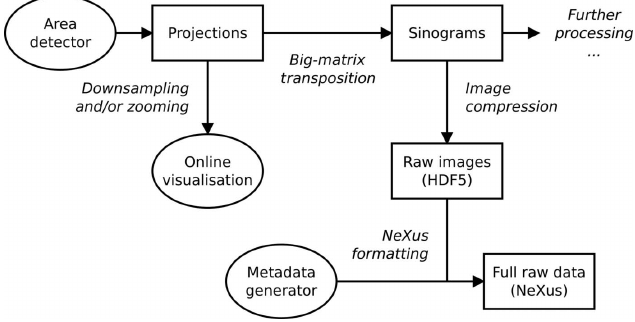
Figure 5 A partial data-pipe graph for a simple high-throughput tomography